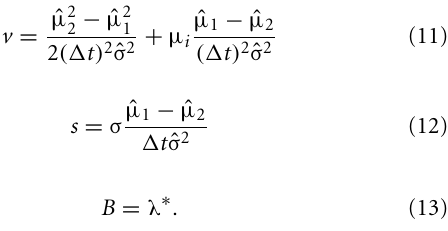
FIGURE 1 | Schematic of the components of the Bayesian model and how they interact when making decisions at a time point t within a trial. In the physical environment a stimulus is presented by the experimenter and observed by the subject. Components inside the shaded rectangle model internal processes of the subject. Sensory processes in the subject’s brain translate the stimulus into an abstract representation x t (e.g., in a feature space). The input process (i) of the Bayesian model approximates this translation by mapping the stimulus identity (decision alternative A i out of M alternatives) to a value x t drawn from a Gaussian distribution with mean